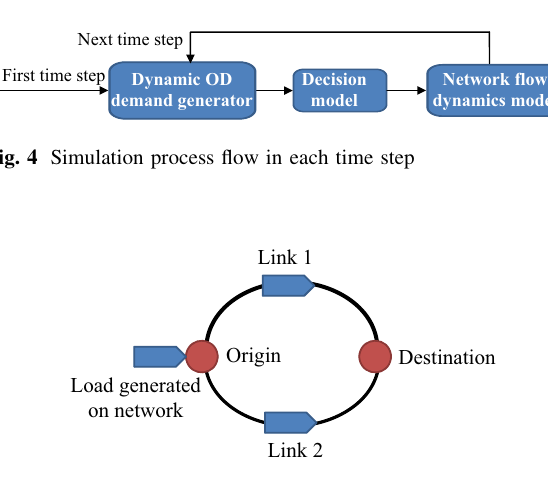
Fig. 5 First scenario network scheme